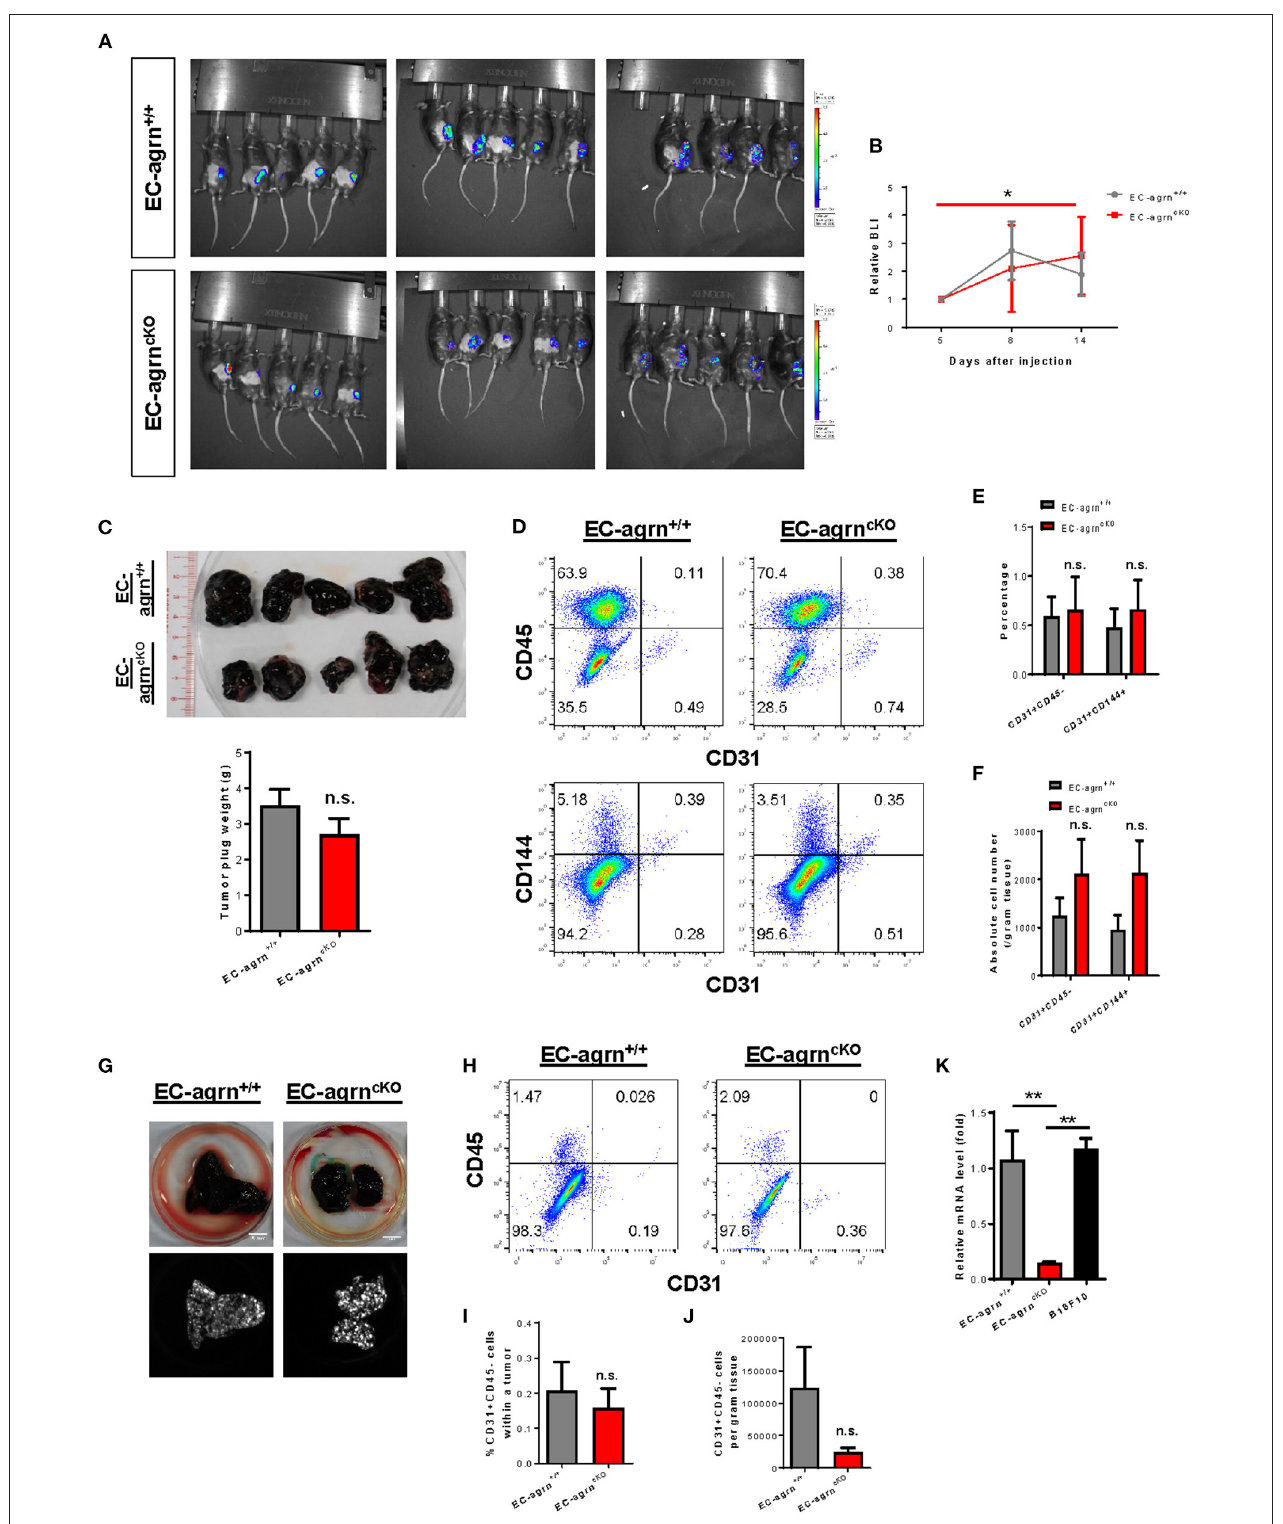
FIGURE 4 | Endothelial agrin is dispensable for tumor angiogenesis during tumor growth and metastasis. (A) Longitudinal in vivo optical bioluminescence imaging (BLI) showing the survival and growth of luciferase -expressing B16F10 melanoma cells (1 x 10 6 cells per mouse) at day 5, 8 and 14 after subcutaneous